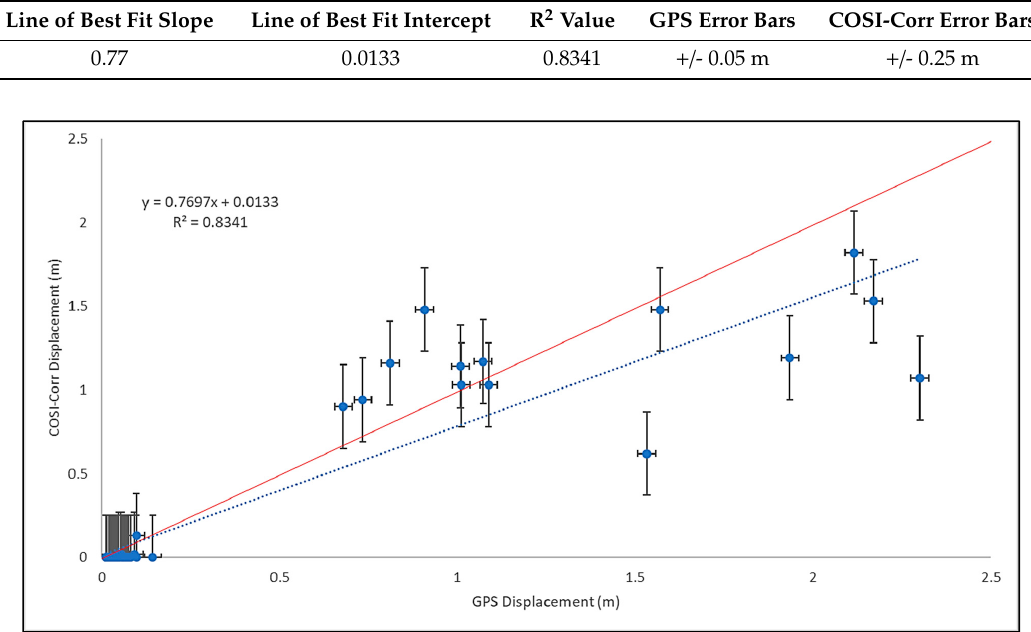
Figure 6. Graphical comparison of displacement measured by GPS (x-axis) and COSI-Corr (y-axis) from 2012 to 2016 at 55 GPS stations. Line of best fit shown as blue dashed line (see Table 4 for additional details). Line of 1:1 slope shown as red line (GPS displacement = COSI-Corr displacement). Table 4. GPS displacement and COSI-Corr displacement comparison between 2012 and 2016 at 55 GPS stations (information from Figure 6).